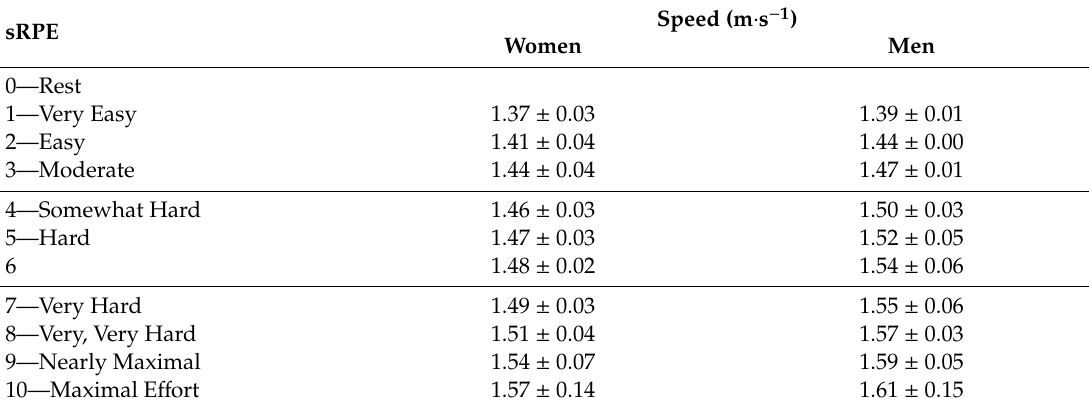
Table 3. Interpolated mean speed for women and men in relationship with